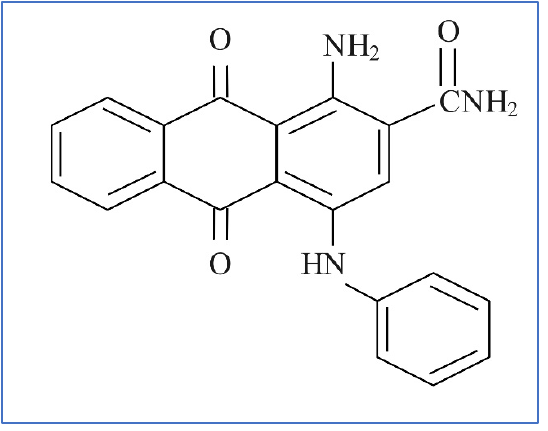
Figure 5. Disperse Blue 6 dye compound.